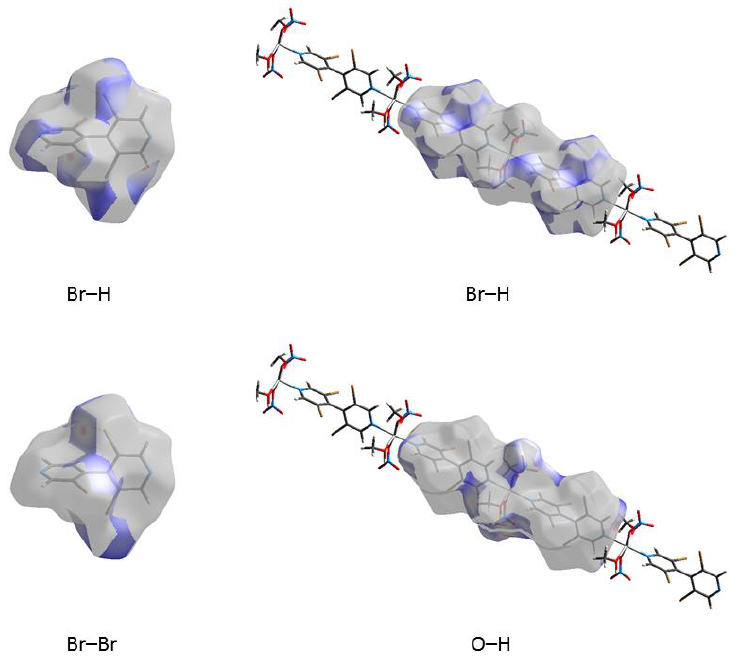
Figure 7. Visualization of Hirshfeld surfaces showing most dominated interatomic contacts in the X - ray structures 1 ( left ) and 2 ( right ).